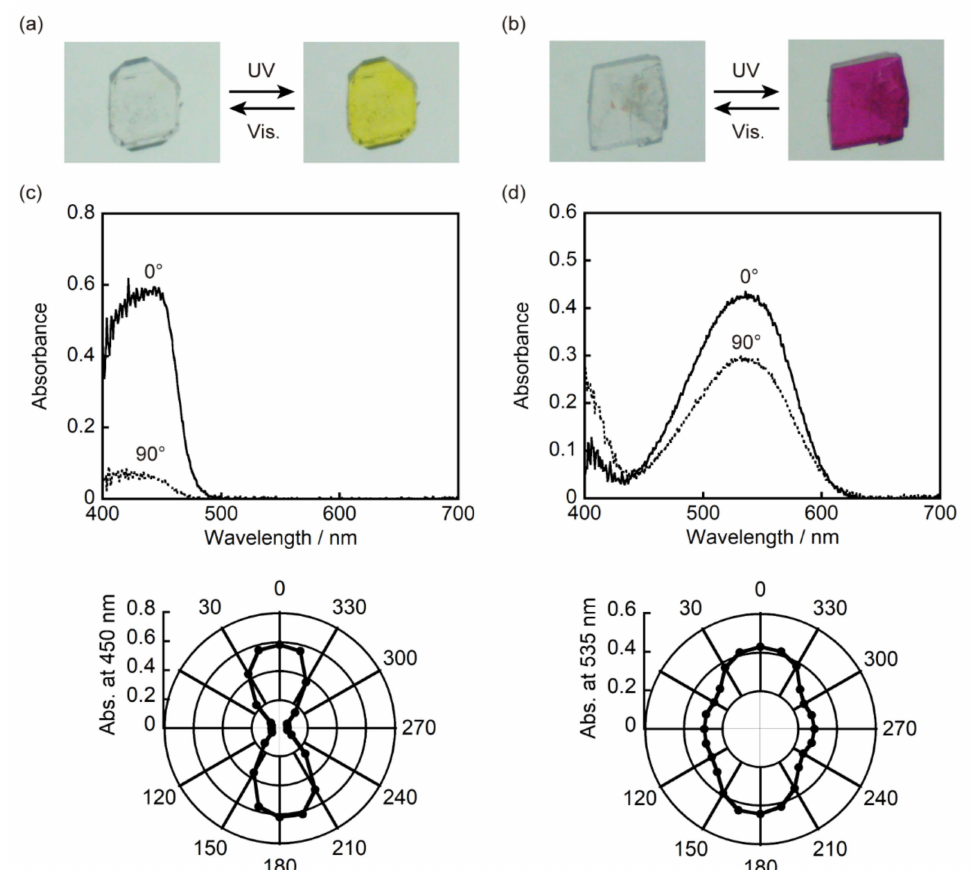
Figure 3. Photographs of photoinduced color changes of single-component crystals of 1a ( a ) and 2a ( b ). Polarized absorption spectra and polar plots of absorbance of the yellow 1a crystal ( c ) and the red 2a crystal ( d ) after irradiation with 365 nm light. The absorption spectra of the crystals of 1a and 2a were measured on ( − 1 1 0) and (1 1 1) faces, respectively (see Figure S3). The direction of 0 ◦